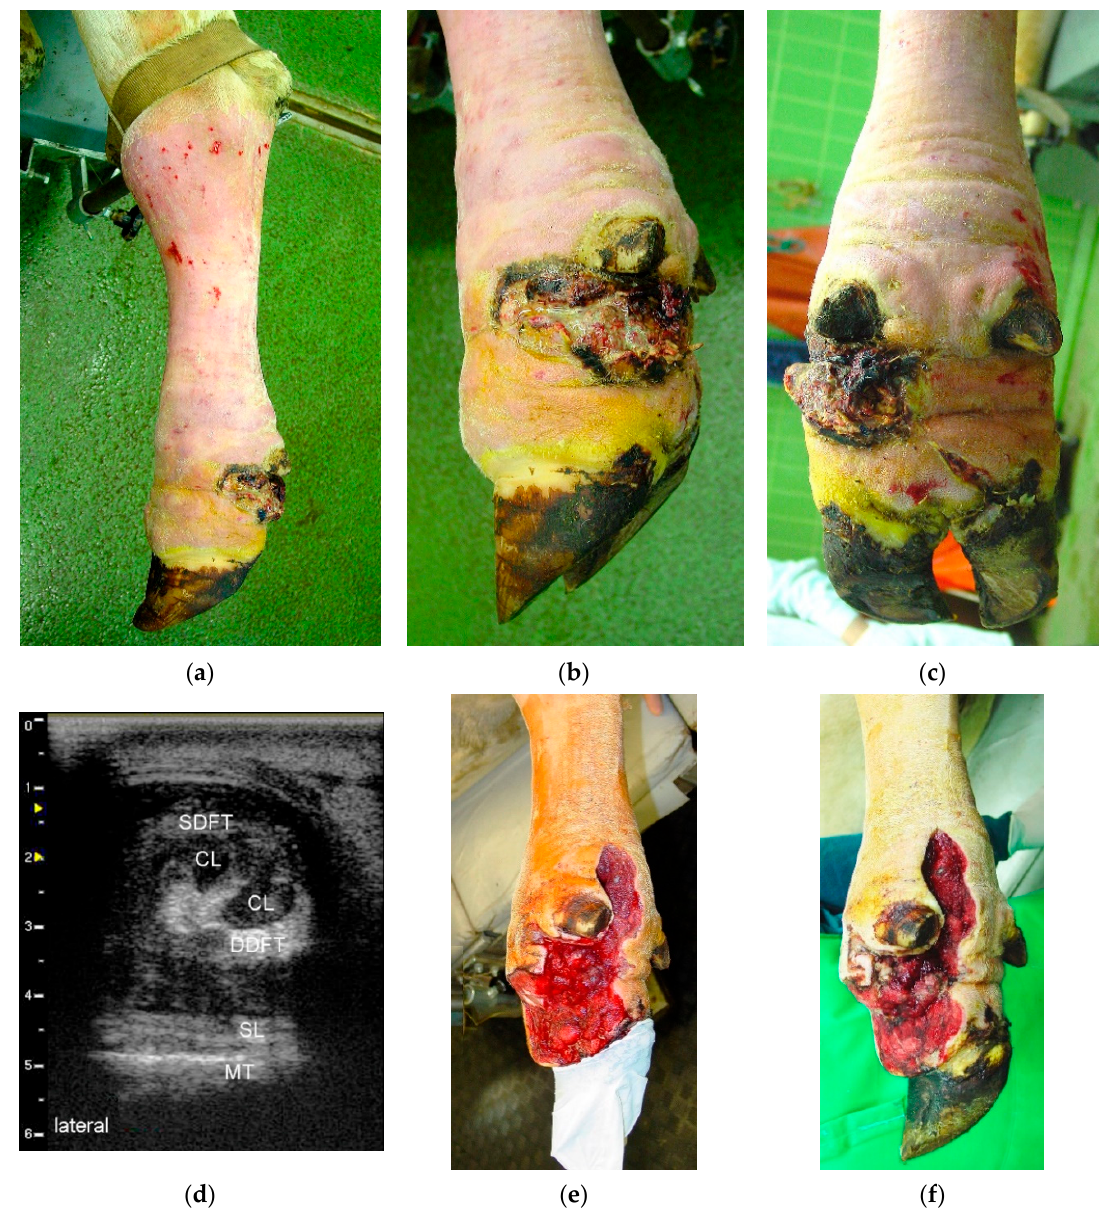
Figure 3. ( a ) Left hind limb of a three-year old Fleckvieh cow with the leg restrained for surgery; ( b ), ( c ) Lateral and plantar view of a 14-day-old wound above the lateral DFTS with marked hypergranulation and purulent exudate. Fibrinous-purulent tenosynovitis of the left lateral DFTS was diagnosed, as well as purulent tendinitis of both DFT and a purulent arthritis of the PIP joint; ( d ) Transversal sonogram (7.5 MHz linear probe) of the lateral DFTS approximately 2 cm proximal to the dewclaws showing heterogeneous hypoechoic effusion without flow phenomena and severe circumscribed loss of echogenicity of the DDFT as well as diffuse loss of echogenicity of the SDFT (CL: “core lesion“ caused by purulent disintegration of the tissue of the DDFT). There is marked effusion of the DFTS. SL: one of the suspensory ligament branches, MT: surface of the metatarsal bone. ( e ), ( f ) Status at 4 and 8 days postsurgery, respectively.